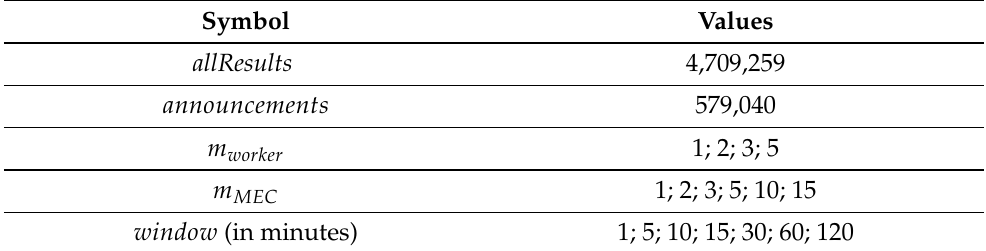
Table 1. Default parameter